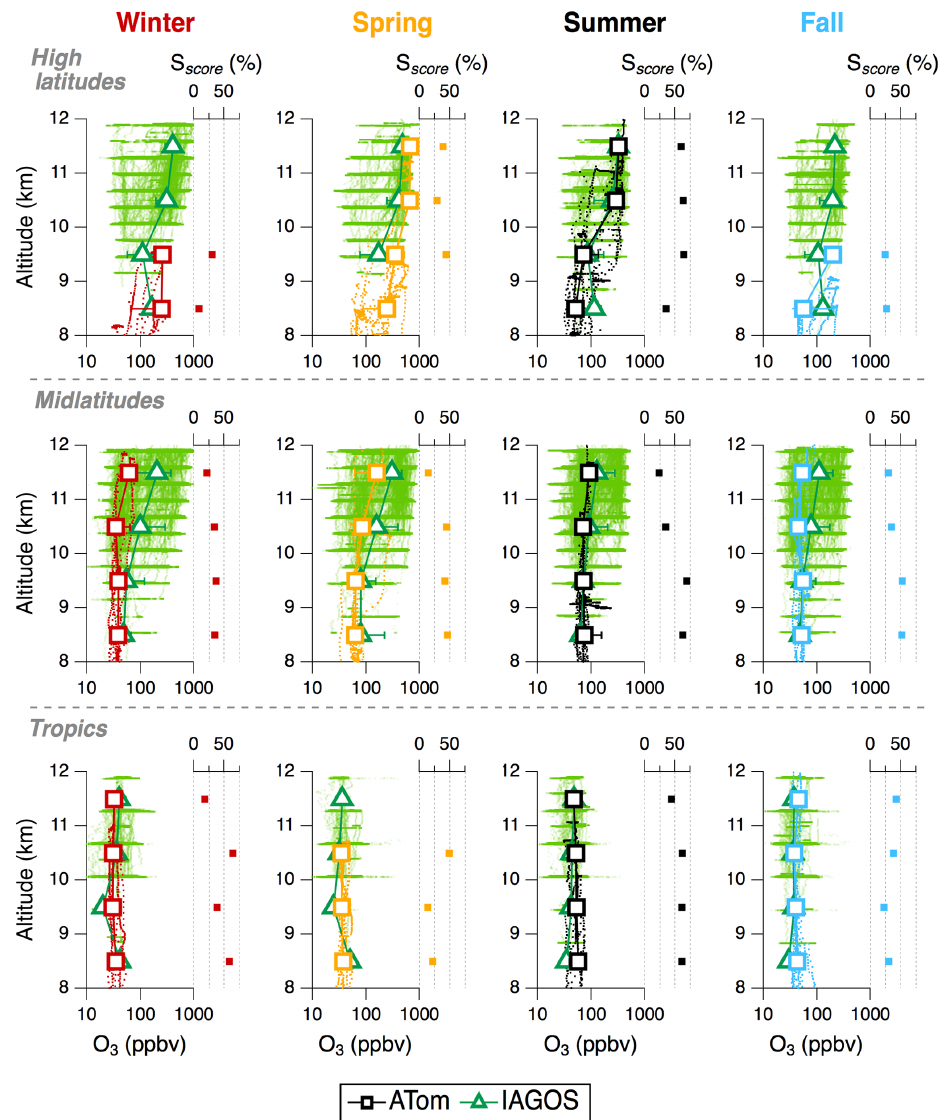
Figure 7. Seasonal comparison of 1km binned ATom (colored squares) median O 3 with IAGOS (green triangles) in the northern Atlantic UTLS. Markers indicate the median, and the bars are the 25th and 75th percentiles. The three different rows indicate the latitudinal bands. The four columns indicate the seasons. The green dots show every O 3 data point measured by IAGOS flights for the timeframe indicated in Table